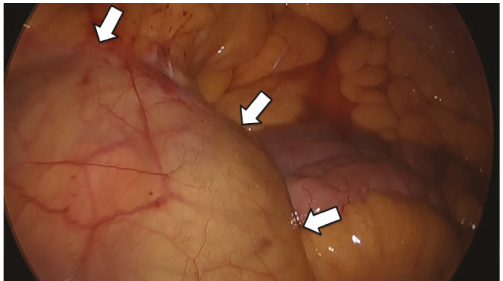
Figure 2: Photograph showing laparoscopic fi ndings during surgery of the distended small intestine and ascites under the ascending